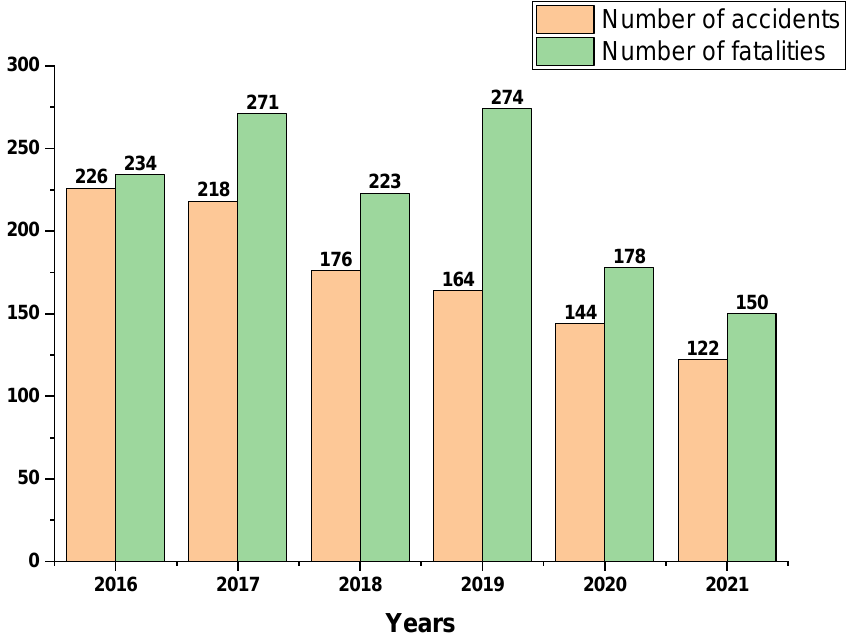
Figure 1. The number of chemical accidents and fatalities in China, 2016 – 2021.